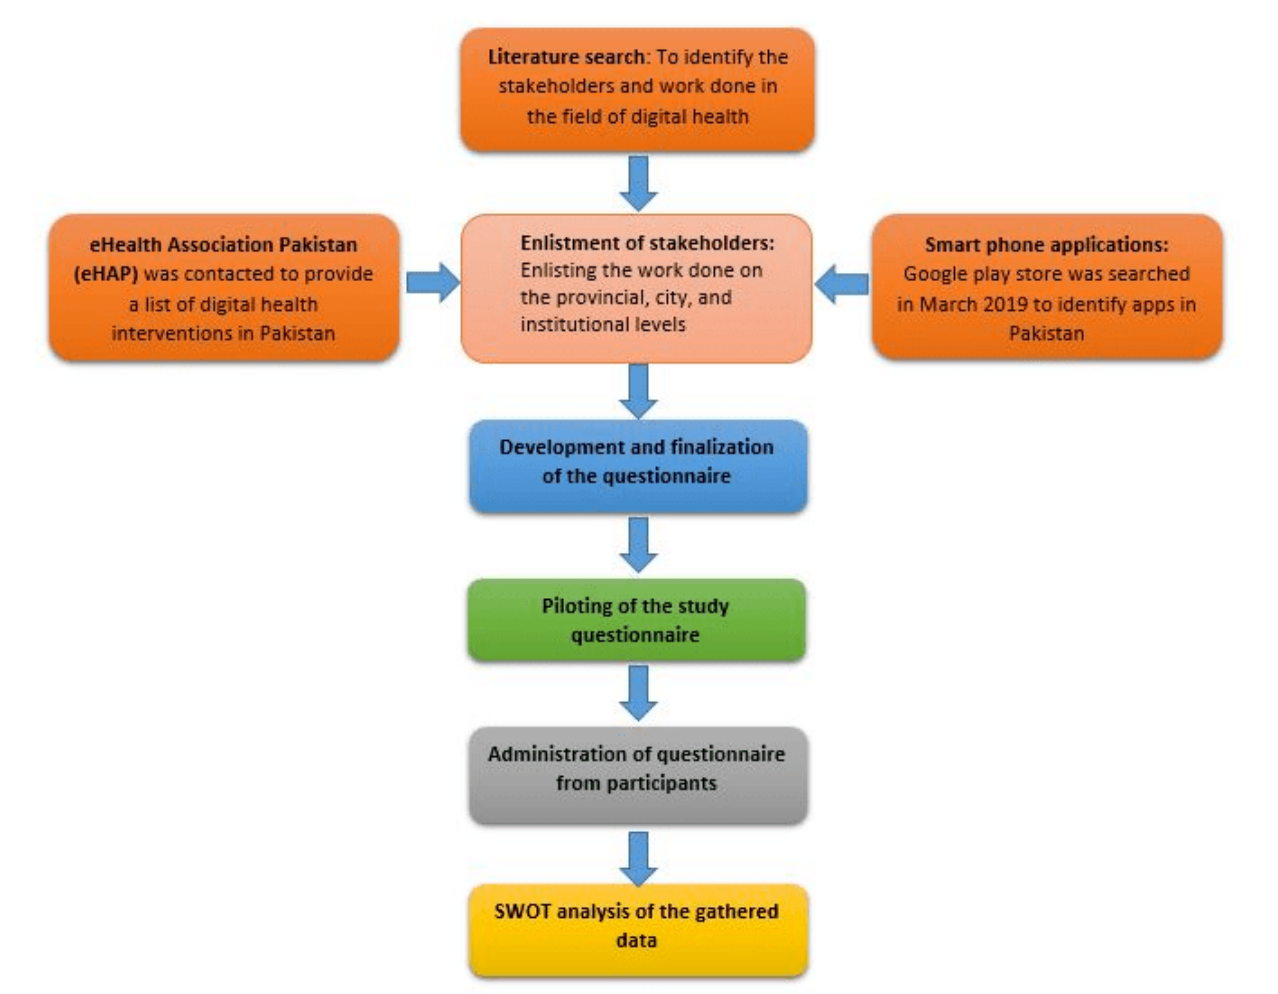
Figure 1. Study flow and major components of the study